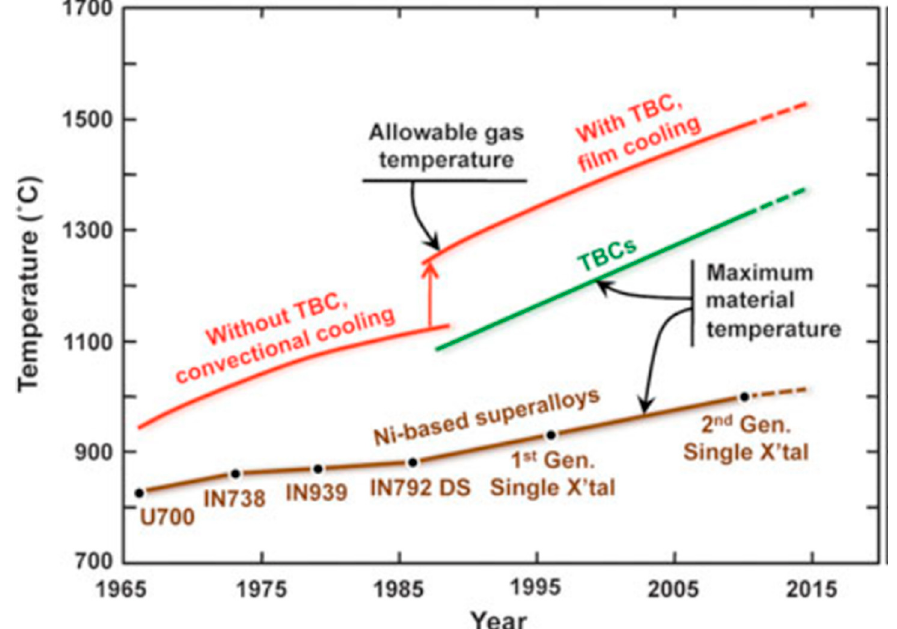
Figure 3. Progression of temperature capabilities of Ni-based superalloys and thermal-barrier coating (TBC) materials over the past 50 years. The red lines indicate progression of maximum allowable gas temperatures in engines, with the large increase gained from employing TBCs. Based on a diagram from the late Professor Tony Evans [2].